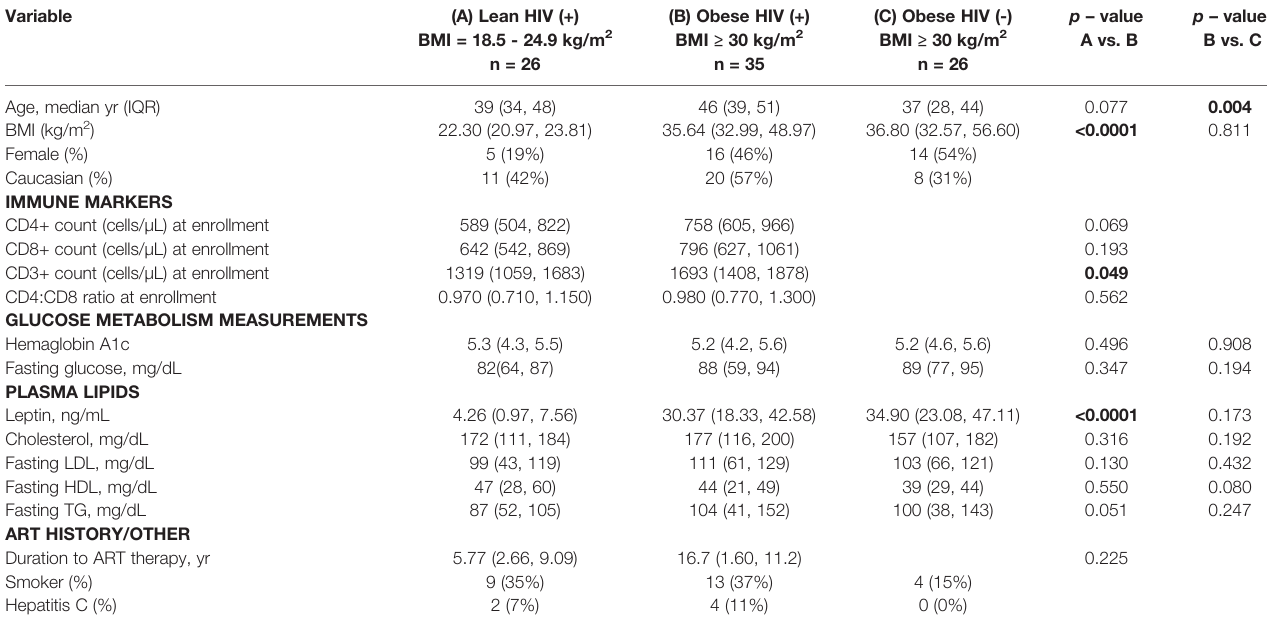
TABLE 1 | Demographic and Clinical Characteristics of Study Participants.